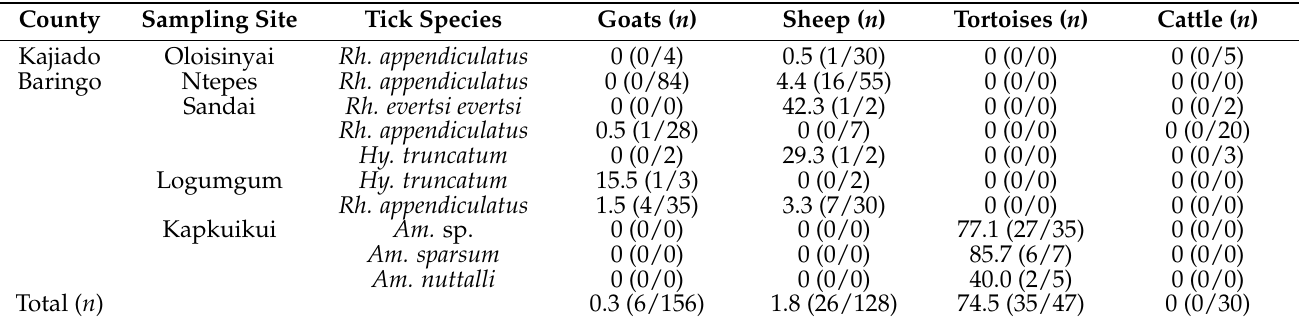
Table 1. Estimated individual-level JMTV prevalence in ticks collected from different